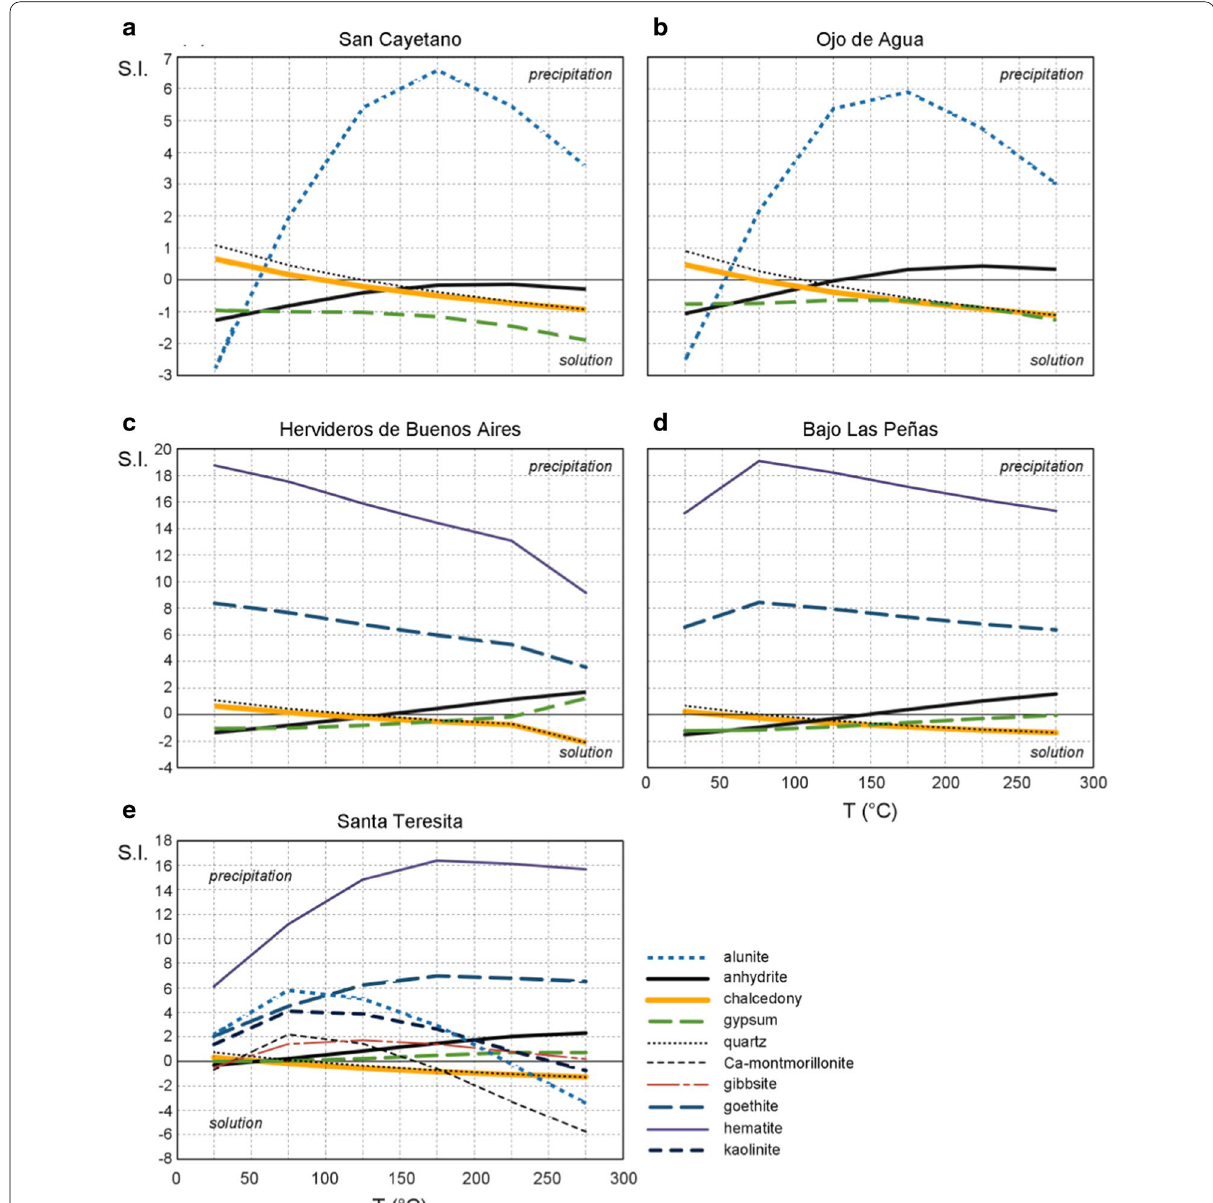
Fig. 11 Temperature vs Saturation Index (S.I.) for various minerals in the studied thermal springs, and corresponding fields of precipitation and solution related to the equilibrium line (S.I. 0). Anhydrite is used as a geothermometric indicator of different equilibrium temperature ranges for = the thermal springs; for San Cayetano ( a ) , Ojo de Agua ( b ), Hervideros de Buenos Aires ( c ), Bajo Las Peñas ( d ) and Santa Teresita ( e ). We use the tangency area between the anhydrite and equilibrium lines to estimate a temperature